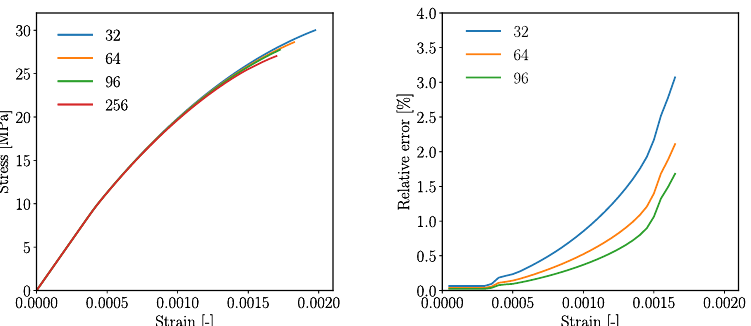
Figure 9. Performance of the k-means-based reduced order scheme in numerical analyses of a simplified concrete meso-structure according to Figure 7 subjected to uniaxial compression. Left: stress–strain curves of four different k-means based reduced samples, right: relative error of the computed axial stress obtained for three different numbers of clusters (Results from 256 mortar clusters taken as reference